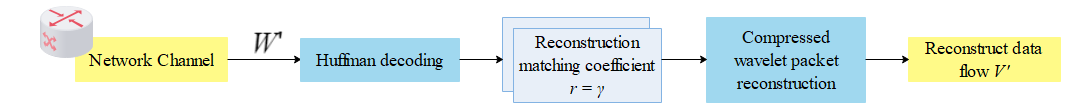
Figure 5. Flow chart of the self-matching wavelet reconstruction and decoding algorithm.